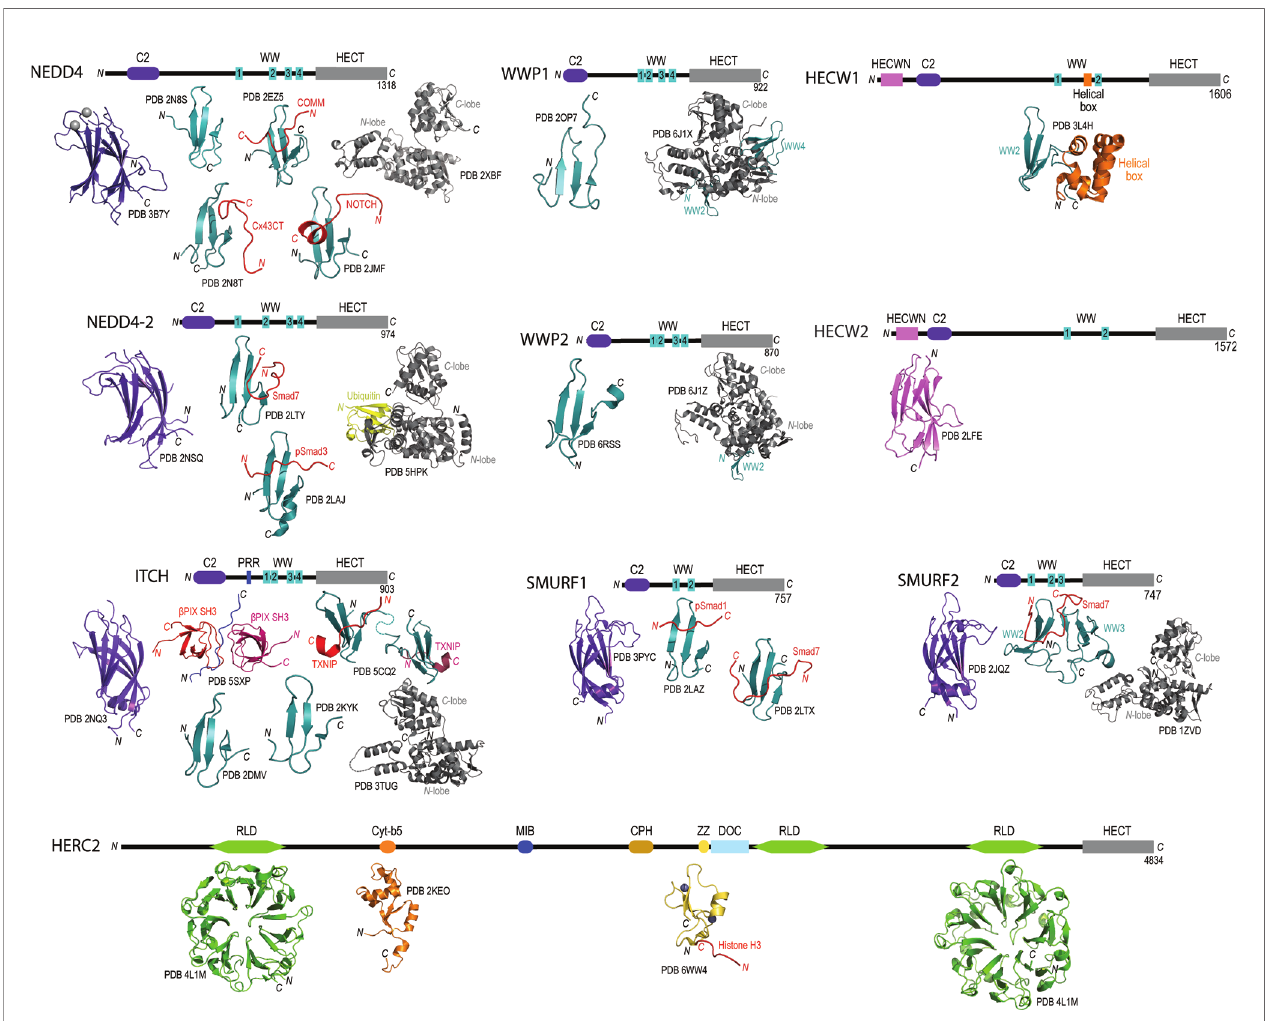
FIGURE 1 | Domain architecture and catalogue of three-dimensional structures of domains for members for the NEDD4L subfamily and HERC2. Domain architecture schematics are based upon annotated boundaries on Uniprot. All of the published or publicly available 3D structures were visualized using PyMol. NEDD4 – C2 domain bound to calcium (purple and silver spheres; PDB 3B7Y), WW domain 1 (PDB 2N8S) (86), WW domain 2 (cyan) in complex with phosphorylated Cx43CT (red; PBD 2N8T) (86), WW domain 3 (cyan) in complex with COMM (red; PDB 2EZ5) (87), WW domain 4 (cyan) in complex with NOTCH (red; PDB 2JMF) (88), and HECT domain (grey; PDB 2XBF) (89). NEDD4-2 – C2 domain (purple; PDB 2NSQ), WW domain 2 (cyan) in complex with Smad7 (red; PDB 2LTY) (90), WW domain 3 in complex with phosphorylated Smad3 (PDB 2LAJ) (91) HECT domain in complex with ubiquitin (PDB 5HPK) (92). ITCH – C2 domain (purple; PDB 2NQ3), proline-rich region (green) with b Pix SH3 domains (reds; PDB 5SXP) (93), WW domain 1 (cyan; PDB 2DMV), WW domain 2 (cyan; PDB 2KYK), WW domains 3 and 4 (cyan) in complex with TXNIP peptide (red; PDB 5CQ2) (94), and HECT domain (grey; PDB 3TUG). WWP1 – WW domain 4 (cyan; PDB 2OP7), and WW domains 2, 3 and 4 (cyan) with HECT domain (grey; PDB 6J1X) (95). WWP2 – WW domain 4 (cyan; PDB 6RSS) (96), and WW domains 2, 3 and 4 (cyan) with HECT domain (grey; PDB 6J1Z) (95). SMURF1 – C2 domain (purple; PDB 3PYC), WW domain 1 (cyan) in complex with phosphorylated Smad1 (red; PDB 2LAZ) (91), and WW domain 2 (cyan) in complex with Smad7 (red; PDB 2LTX) (90). SMURF2 – C2 domain (purple; PDB 2JQZ) (97), WW domains 2 and 3 (cyan) in complex with Smad7 (red; PDB 2KXQ) (98), and HECT domain (grey; PDB 1ZVD) (99). HECW1 – Helical box (orange) with WW domain 2 (cyan; PDB 3L4H). HECW2 – HECWN domain (pink; PDB 2LFE). HERC2 – RLD domain 1 (green; PDB 4L1M), Cyt-b5 domain (orange; PDB 2KEO), ZZ domain bound to zinc ions (purple and grey spheres) in complex with Histone H3 tail (red; PDB 6WW4) (100), RLD domain 3 (green; PDB